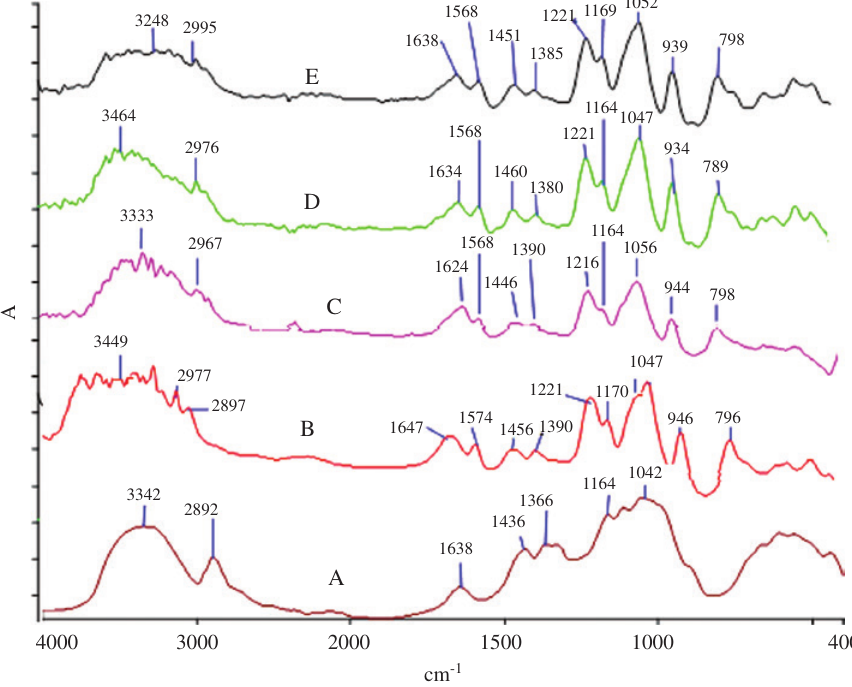
, (C) Cel-PO -Gr0.2, (D) Cel-PO 4 4